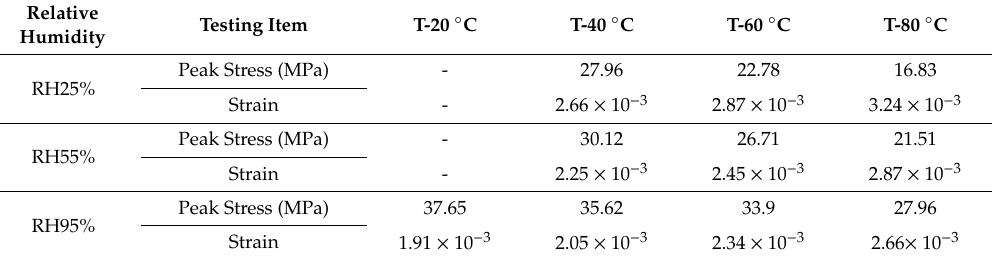
Figure 3. Equipment for uniaxial compression test. Table 5. Test data for peak stress-strain under different curing conditions.